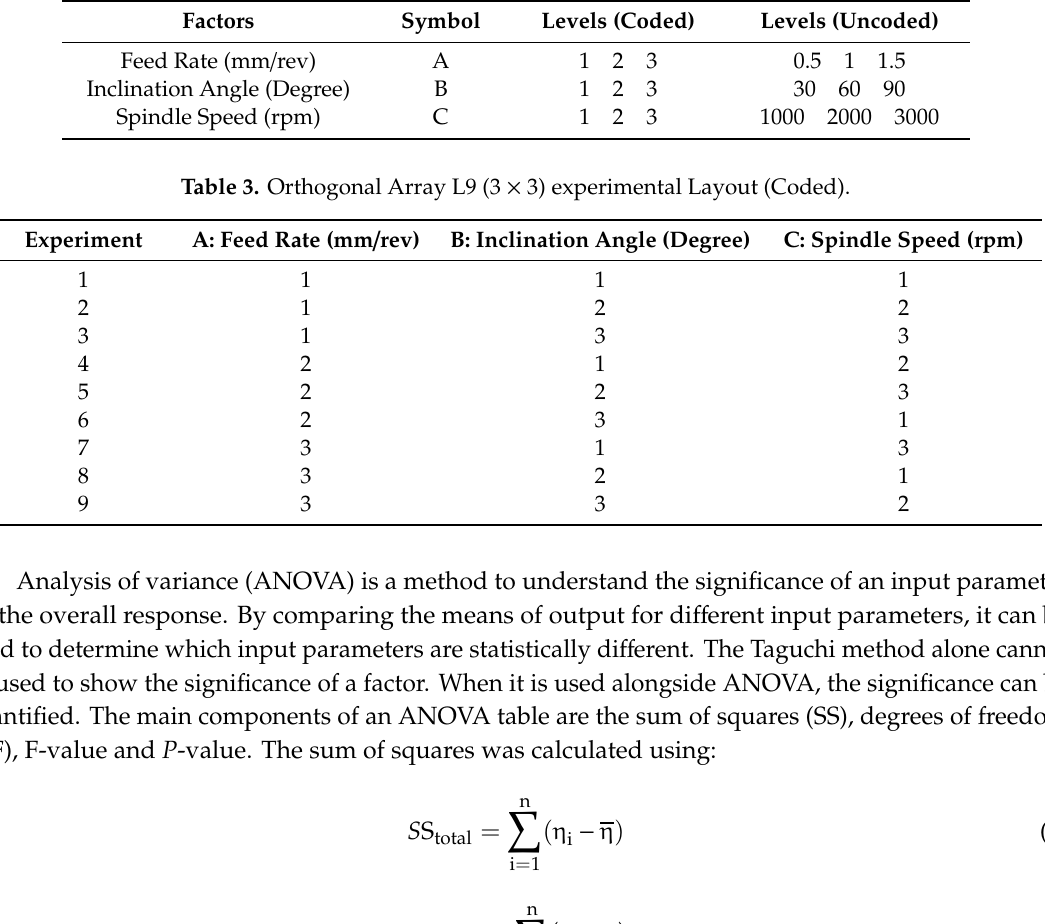
Table 2. Factors and their associated levels.